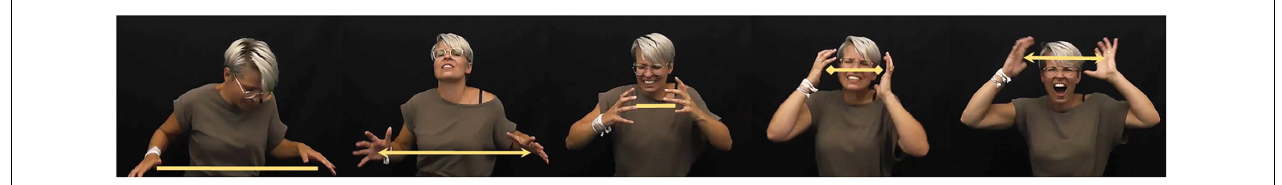
FIGURE 4 | Embodiment of instrumental crescendo—increase in energy in the music, transformed (left to right) into tension in the upper-body, drawing the hands inward and upward until it explodes in a scream-like release (Stolk: Pyscho—Muse, 2020).